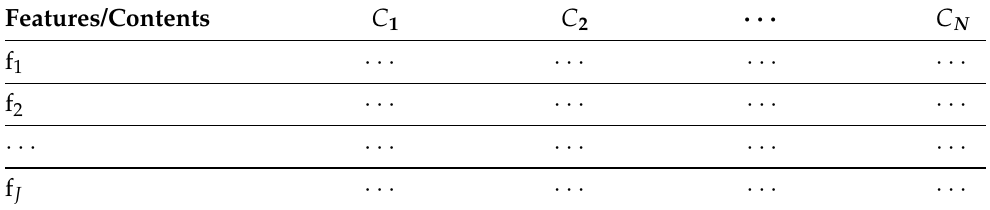
Table 3. Content